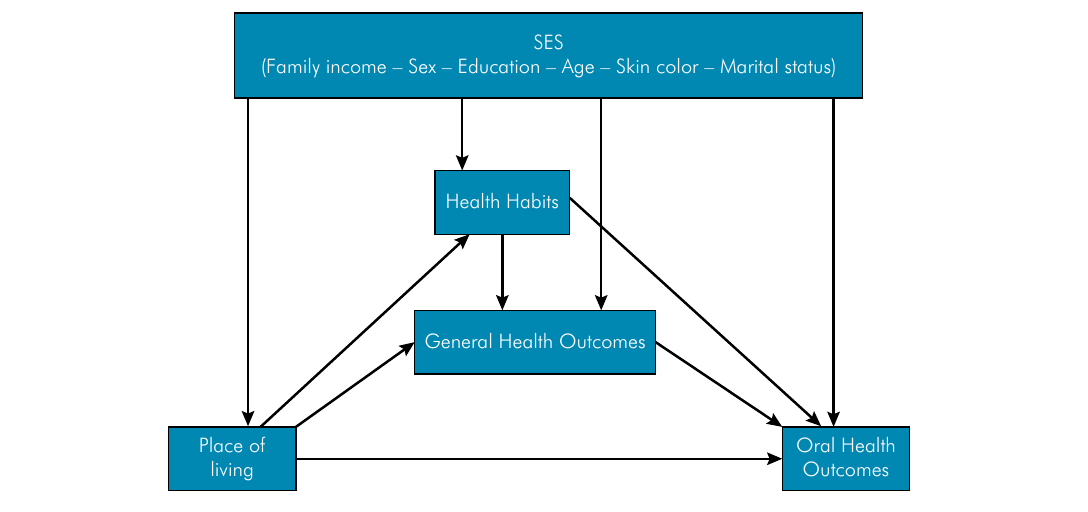
Figure. Conceptual model of the relation between place of living and oral health outcomes considering confounders and possible mediators to properly guide statistical regression